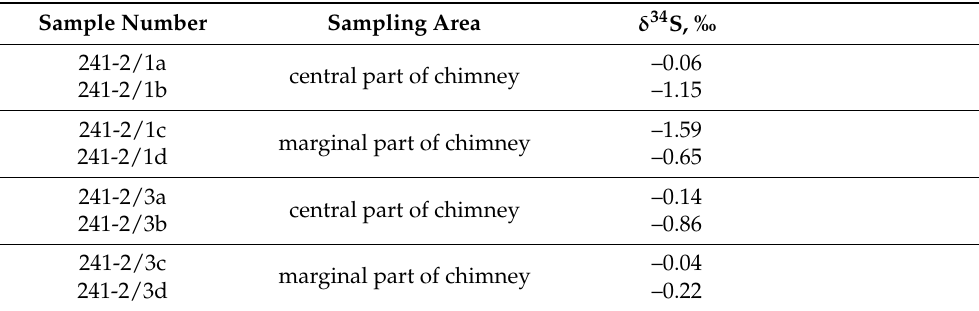
Table 10. S isotopic composition of bulk samples of Zn-rich chimneys from the Irinovskoe hydrother- mal sulfide